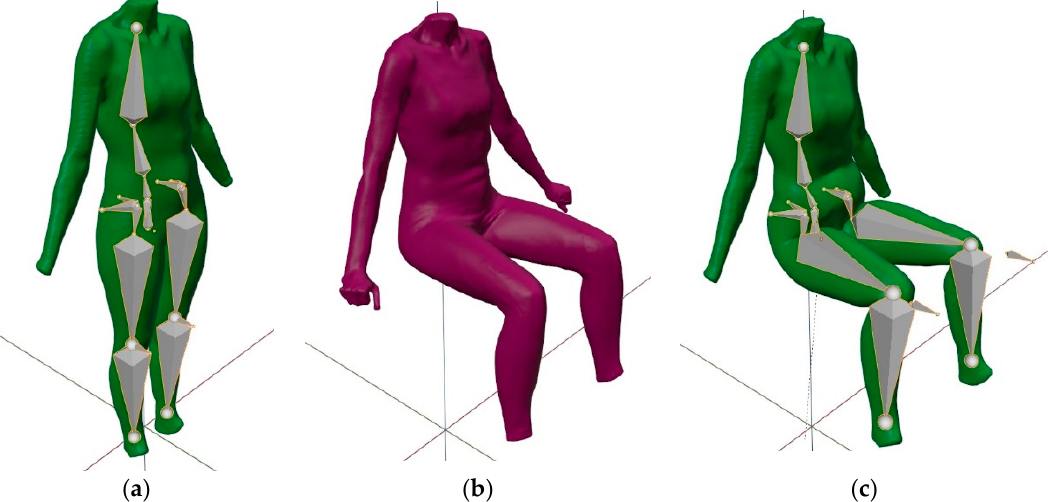
Figure 3. Virtual body models used in this study: ( a ) standing scanned 3D body model with an improved armature, ( b ) sitting scanned 3D body model and ( c ) standing scanned 3D body model, posed with an improved armature, herein called the kinematic sitting 3D body model.